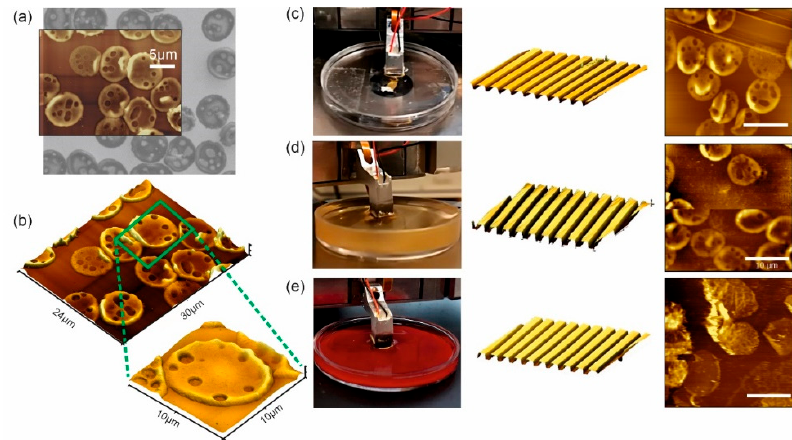
Figure 3. (left) Correlated atomic force microscopy—scanning electron microscopy (AFM—SEM): ( a ) Ultra-flat erythrocyte ghosts on gold were first recorded with the SEM and imaged with the AFSEM ® inside the SEM at the same position. ( b ) Overview and three-dimensional (3D) single erythrocyte AFM image at the same position. Images of ultra-flat erythrocyte ghost cells were taken in various liquids, such as deionized water ( c ), blood serum ( d ) and freshly drawn human blood ( e ). For each liquid, a proof-of-principle measurement of a calibration grid was performed (( c – e ), middle), followed by imaging of erythrocyte ghost cells (( c – e ), right). The grid in ( e ) was recorded in 1:8 diluted blood. Scale bars are 10 μ m for AFM images in ( c – e ).